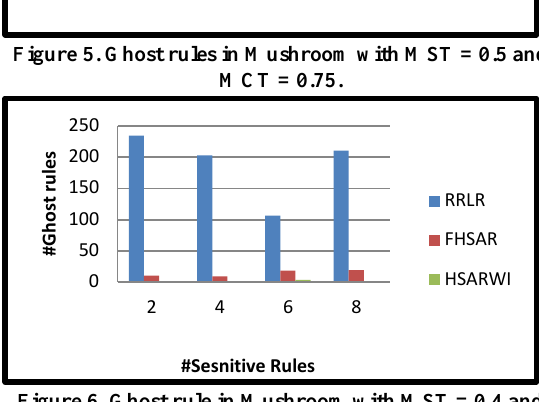
Figure 6. Ghost rule in Mushroom with MST = 0.4 and MCT = 0.6.